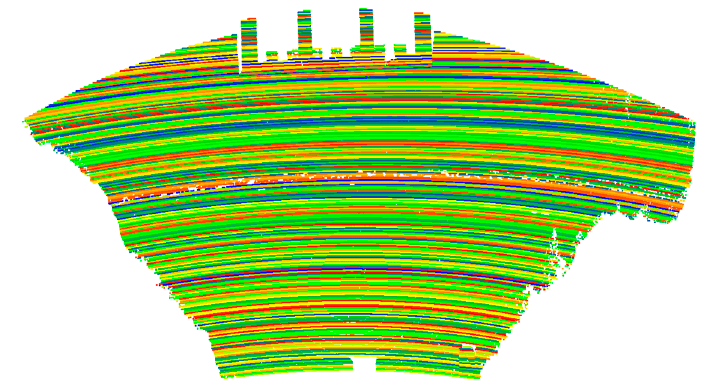
Figure 6. Color rendering of dam arch ring.